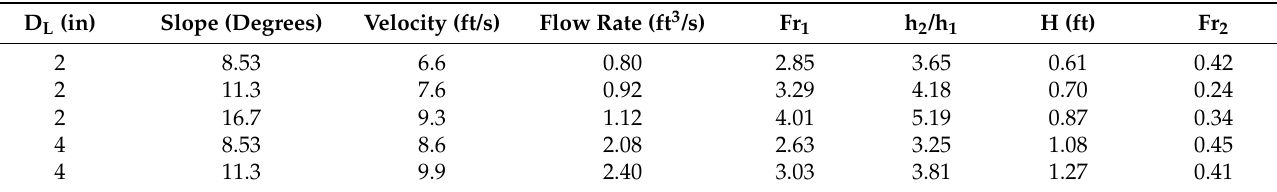
Table 1. Flow Rate Results for the Major